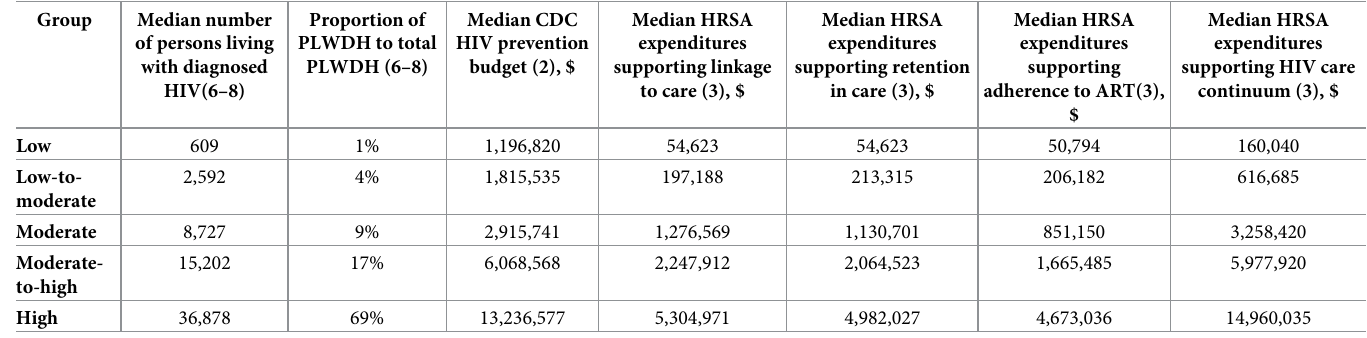
Table 1. Median number of persons living with diagnosed HIV, proportion of persons living with diagnosed HIV (PLWDH), median CDC HIV prevention budget and HRSA expenditures supporting linkage to care, retention in care, and adherence to ART by group. Group Median number of persons living with diagnosed